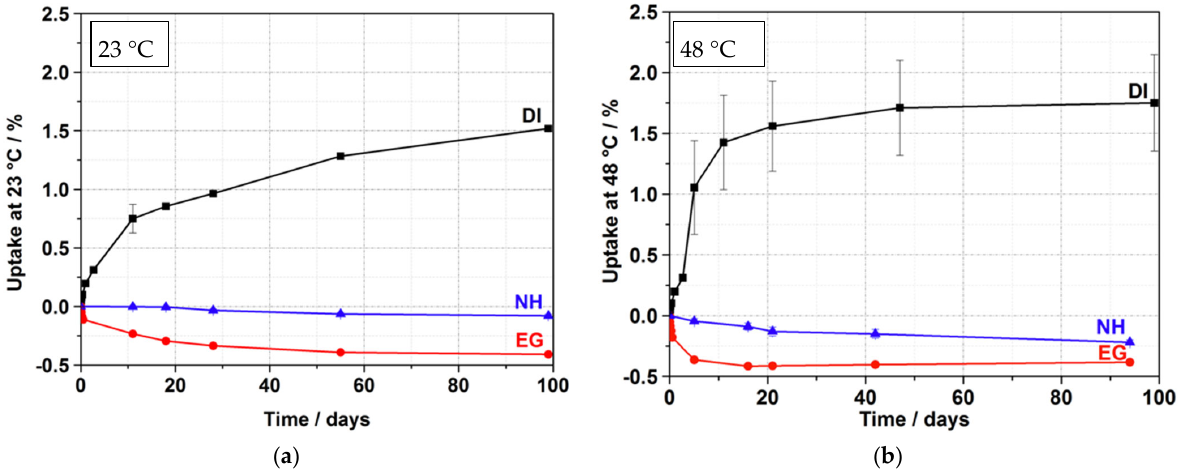
Figure 2. Absorption properties of PMMA stored at 23 °C ( a ) and 48 °C ( b ) in DI, NH, and EG. None of the SCAs led to a strong dissolution of PMMA at 23 °C or 48 °C. Thus, all solvents can be used as SCA for the ESC measurements under dynamic loading. The ab ‐ sorption curve for DI is approximately Fickian, with a weight gain after 100 d of 1.5% at 23 °C (a). This is the expected behavior for a liquid with limited chemical compatibility but small molecular size [20]. Swelling of the material was not observed. The investiga ‐ tions at 48 °C (b) showed that the diffusion takes place at a higher speed and that a plateau is reached after about 50 d. The diffusion rate in PMMA is therefore much higher com ‐ pared to lower temperatures. A possible explanation regarding the large error bar is the strong diffusion rate on one side and the rapid increase in interaction between fluid and polymer. The possible movement allows for water to diffuse into the polymer but also out of the polymer. The steady increase in weight achieved in 100 days at room temperature